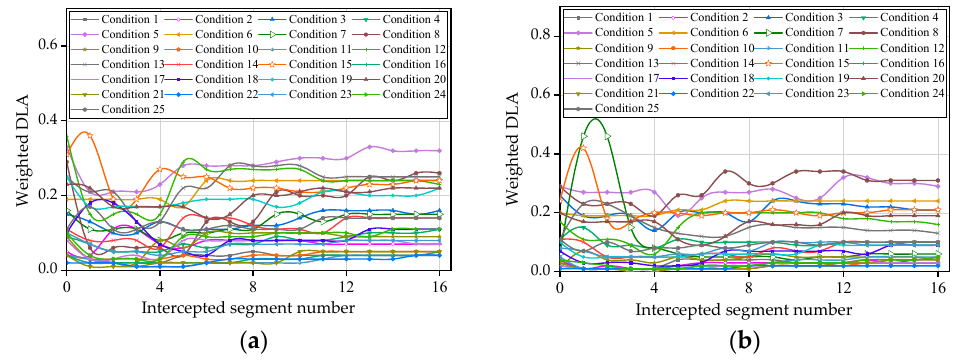
Figure 14. Weighted DLAs of each condition. ( a ) Weighted DLAs for the two-span continuous girder bridge; ( b ) Weighted DLAs for the three-span continuous girder bridges.